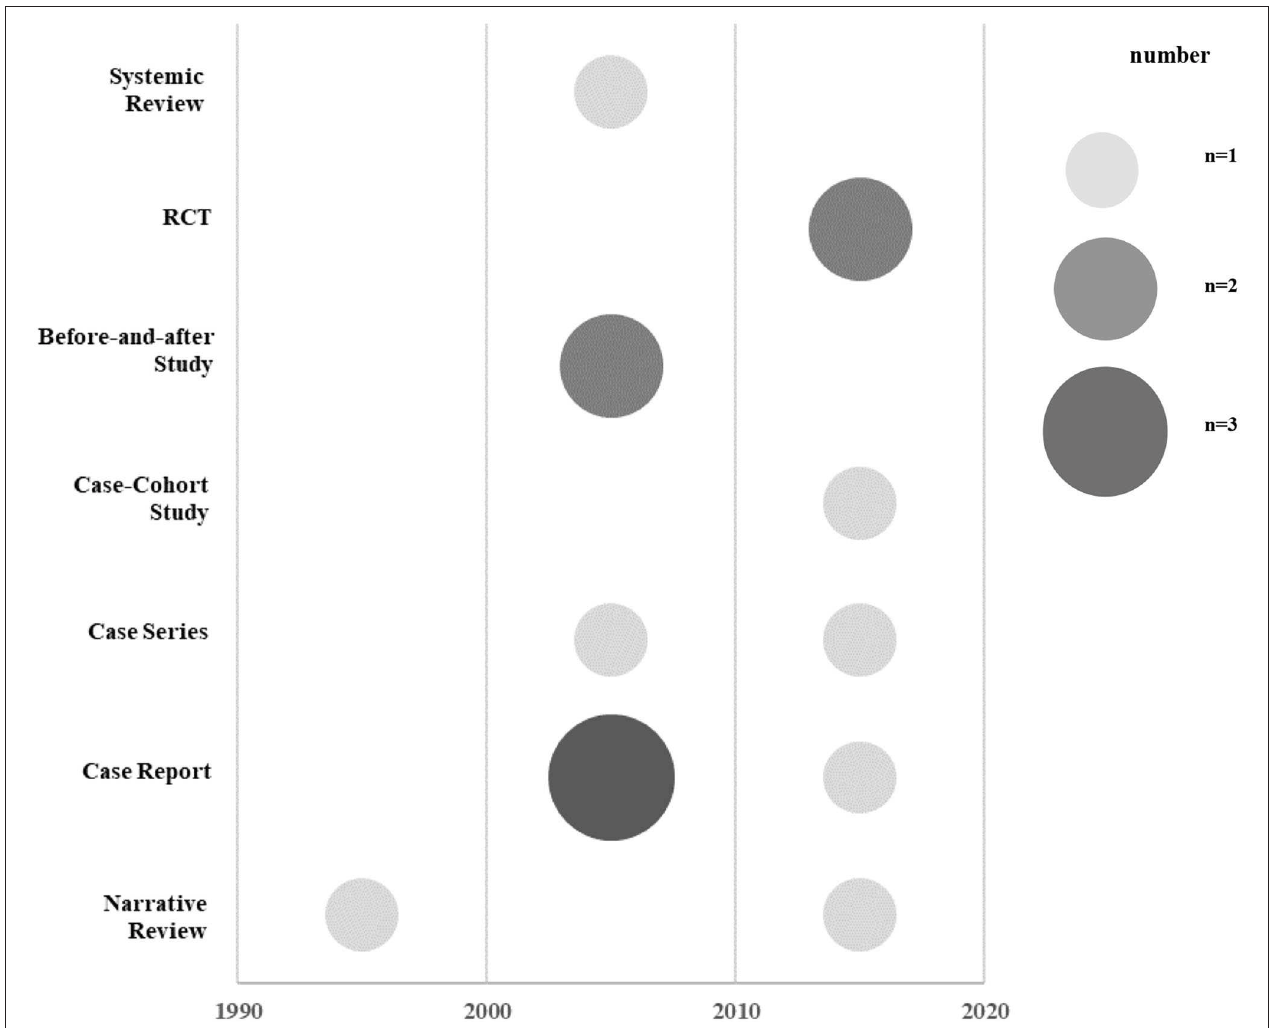
FIGURE 2 | Publication trends of included studies. RCT, randomized controlled